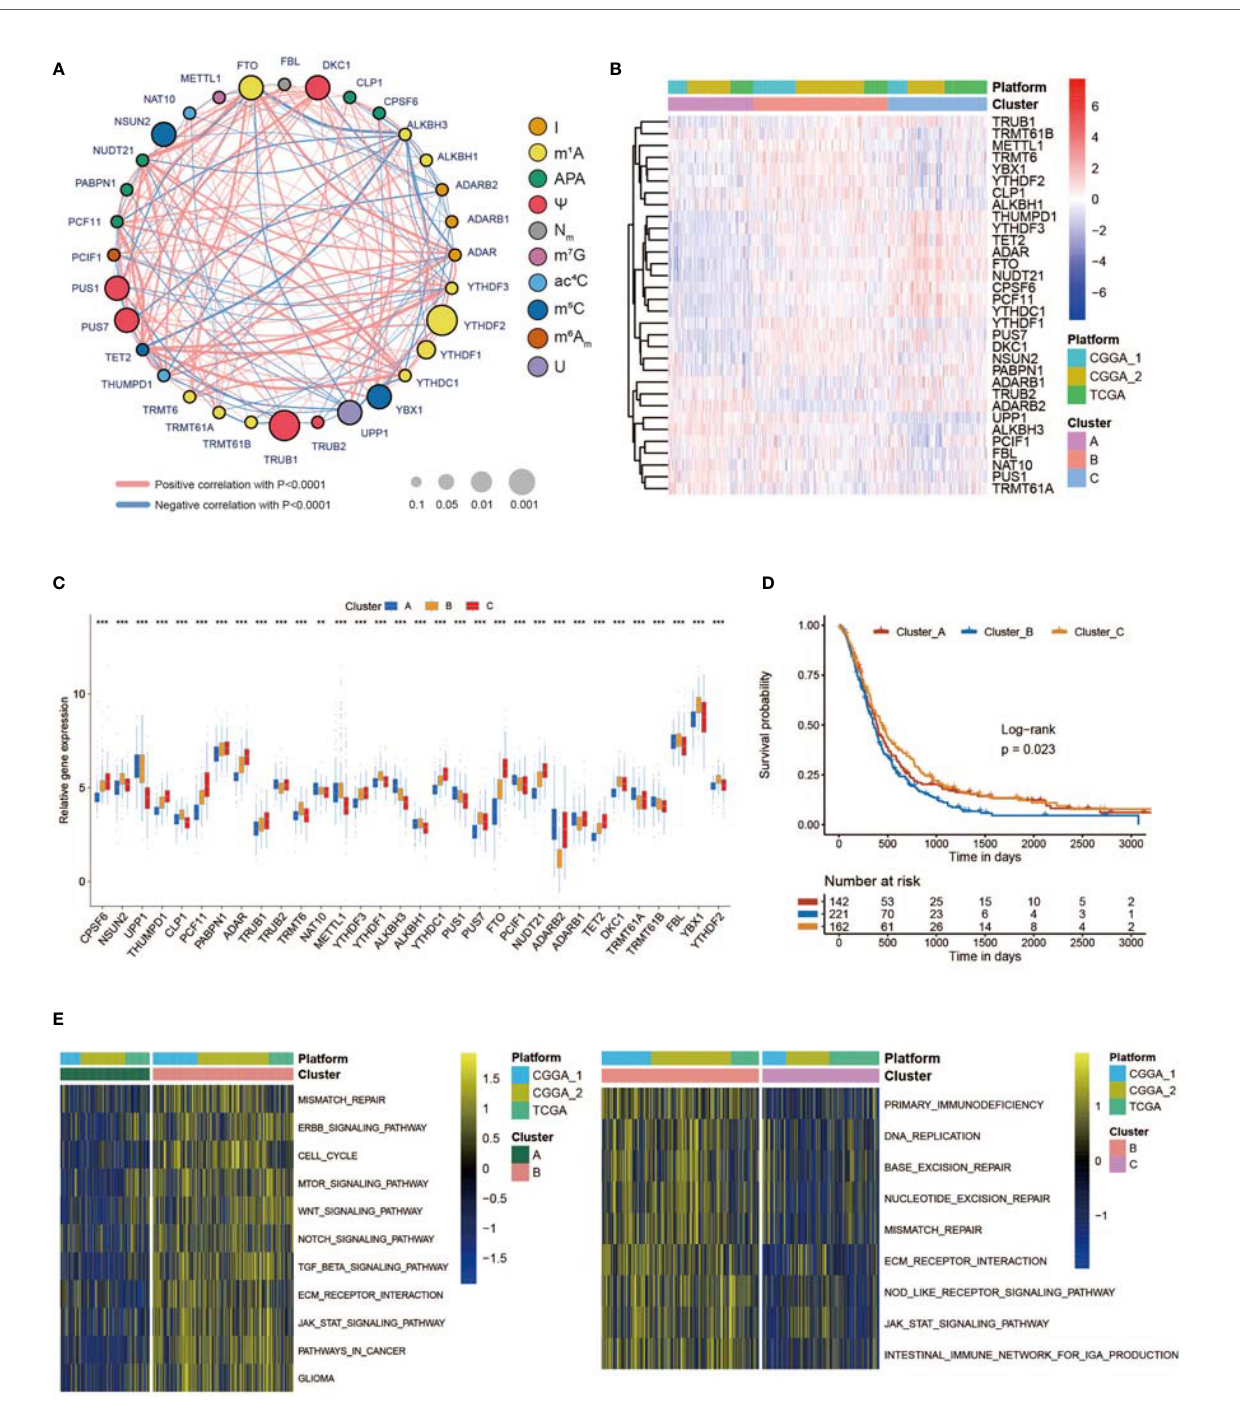
FIGURE 2 | Three RNA modi fi cation patterns of non-m 6 A genes and relative biological functions. (A) Network plot showing the interaction between non- m 6 A RNA modi fi cation genes in GBM. The size of the circle represents the p -value of each gene for the survival prognosis. Black dots represent hazard survival factors, and green dots represent favorable survival factors. The thickness of the lines represents the correlation value between genes. The red and blue lines represent positive and negative correlations, respectively. Ten RNA modi fi cation types are marked with different colors. (B) Heatmap showing the unsupervised clustering of 32 non-m 6 A RNA modi fi cation regulators in 539 GBM patients. Each column represents a patient, and each row represents a non-m 6 A RNA modi fi cation regulator. (C) Expression of 32 non-m 6 A RNA modi fi cation genes between three non-m 6 A RNA modi fi cation patterns. (D) Kaplan – Meier curves showing the survival information of three non-m 6 A RNA modi fi cation patterns. (E) Heatmap showing the results of GSVA enrichment between different non-m 6 A RNA modi fi cation patterns. * means P<0.05; *** means